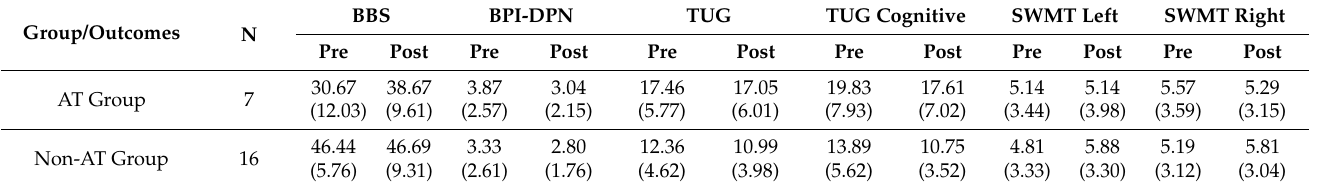
Table 5. Baseline and Post-intervention scores for balance, mobility, pain, and sensation for AT and non-AT group.